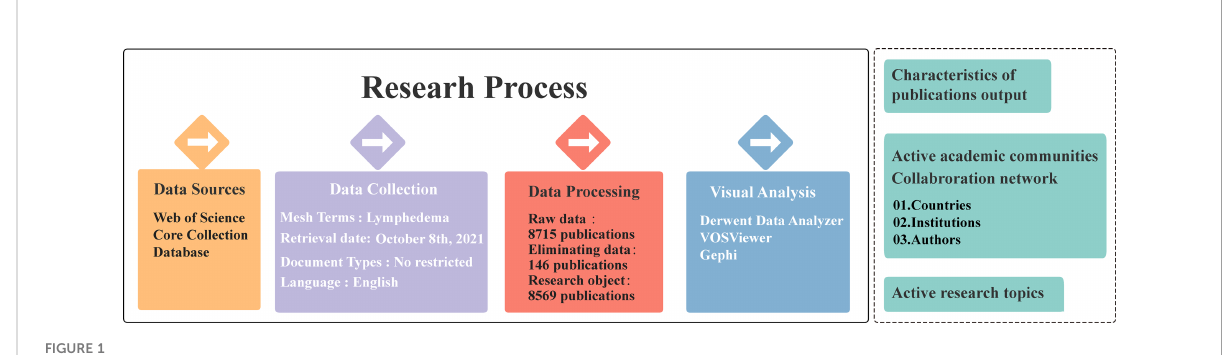
FIGURE 1 The detailed integrated work fl